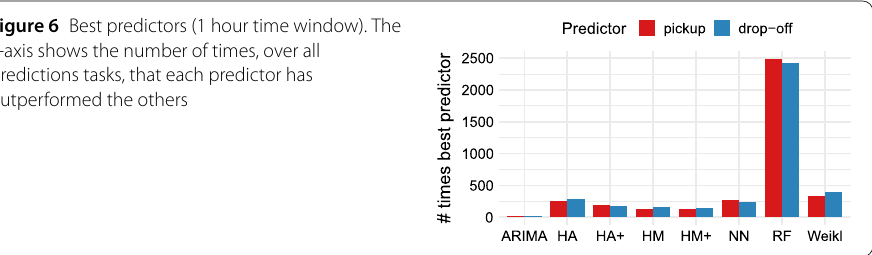
Figure 6 Best predictors (1 hour time window). The y-axis shows the number of times, over all predictions tasks, that each predictor has outperformed the